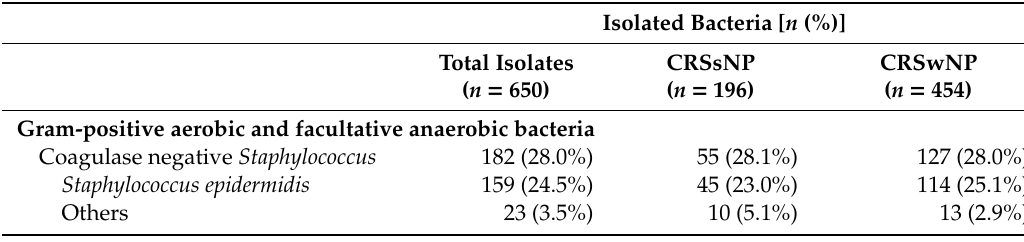
Table 3. Number and percentage of bacterial isolates ( n = 650